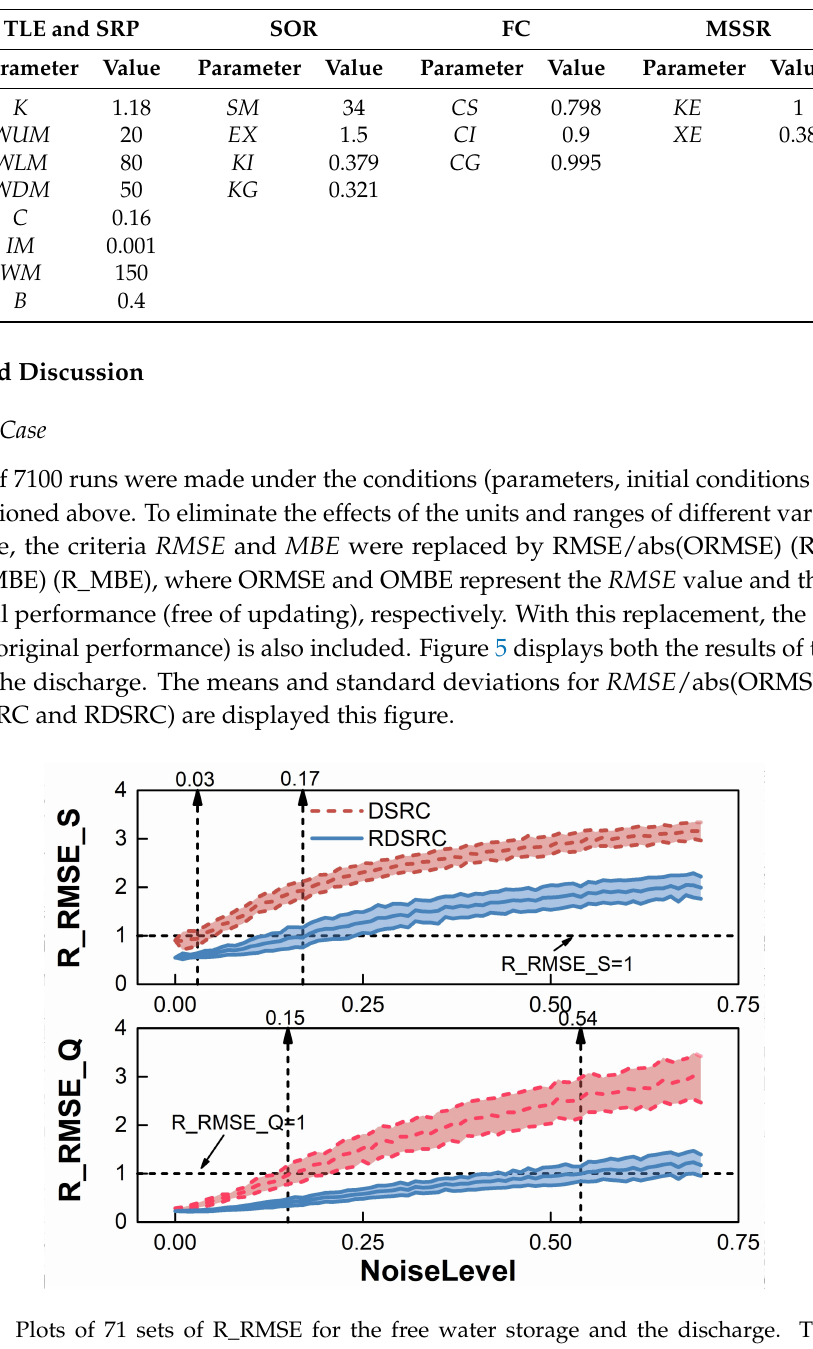
Figure 5. Plots of 71 sets of R_RMSE for the free water storage and the discharge. The labels “R_RMSE_S” and “R_RMSE_Q” represent the results of the free water storage and the discharge, respectively. A straight line in the middle represents mean values of 100 flood events (per level) and half the width of the filled area represents the corresponding standard